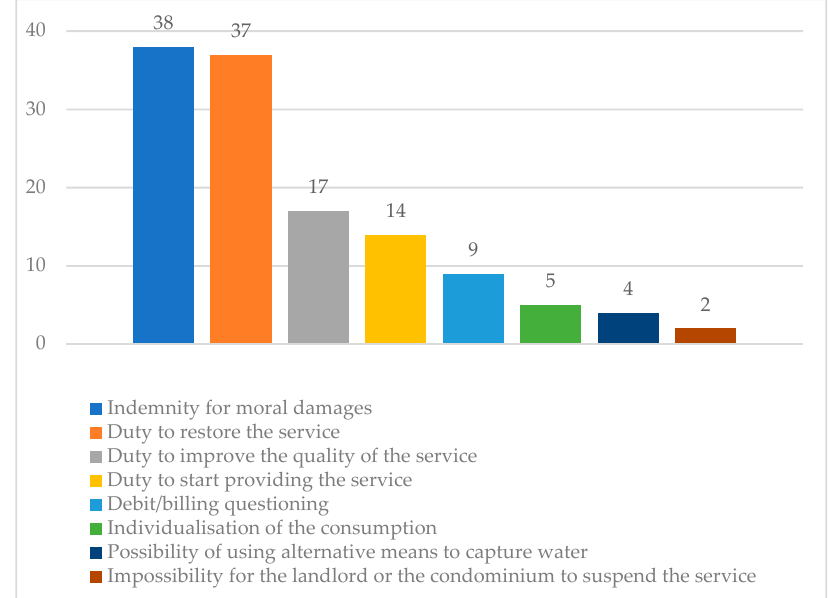
Figure 5. Most Frequent Topics within the area of water supply.